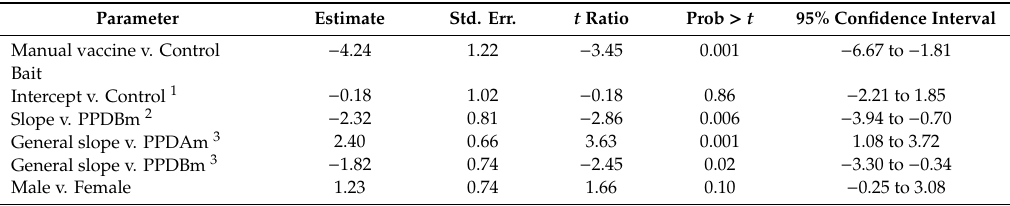
Table 12. Analysis of variance of Disease Burden Score (DBS) using combined PPDAm as well as PPDBm to measure post-vaccination immunology.